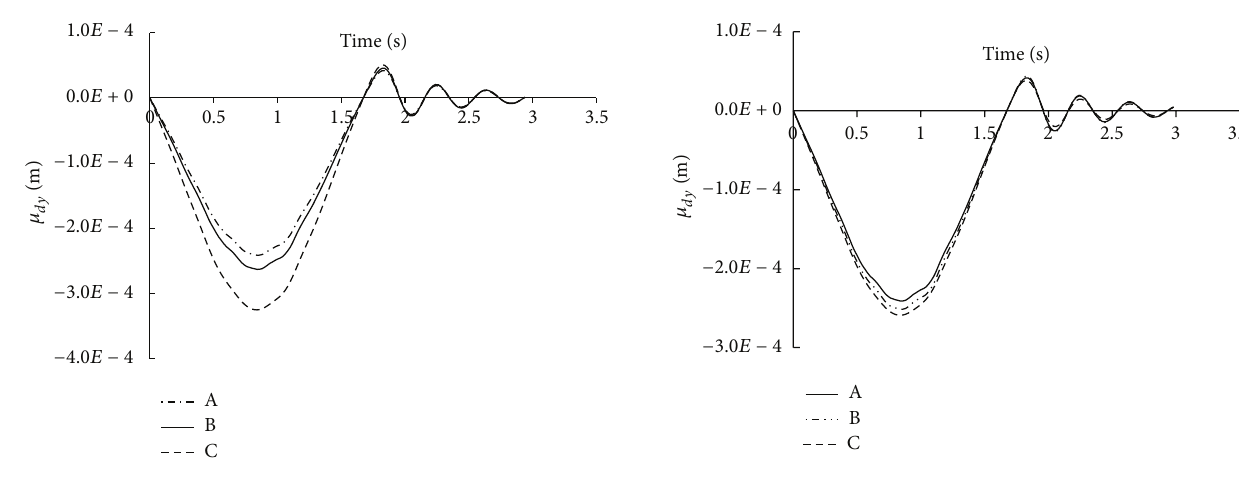
Figure 22: Effect of flexibility on mean response of bridge, (A) 𝐼 = 5.3 × 10 6 N-m 2 , (B) 𝐸 𝐸 V V 8.2 × 10 10 N-m 2 .